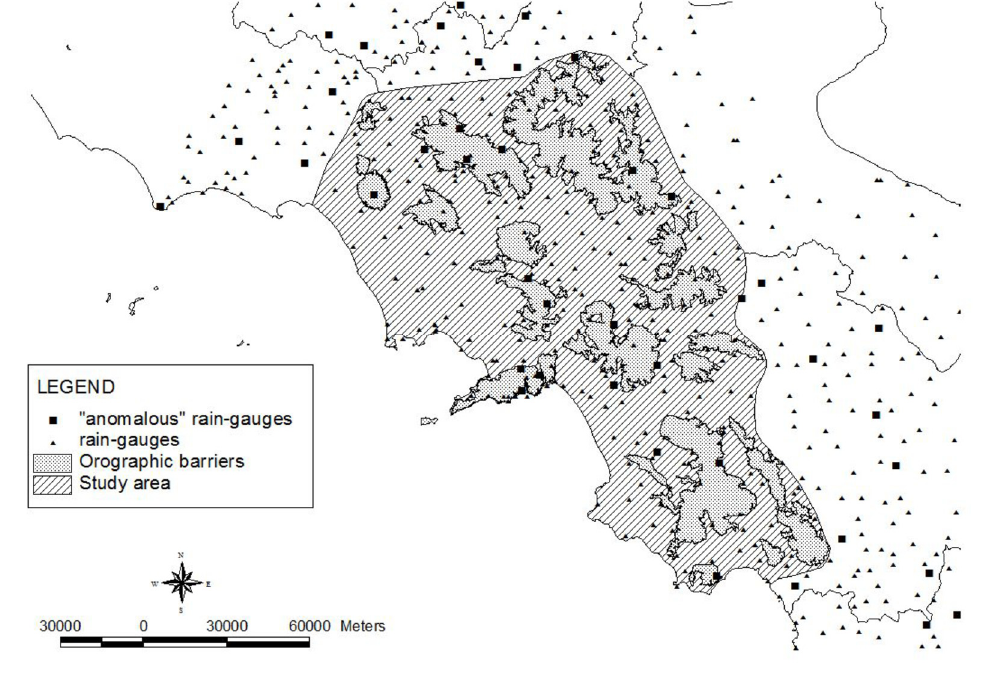
Figure 3. Location of the study area with the rain gauges (triangles), the “anomalous” rain gauges (squares) (Section 2.3.2 and [7]) and the orographic barriers (solid grey)